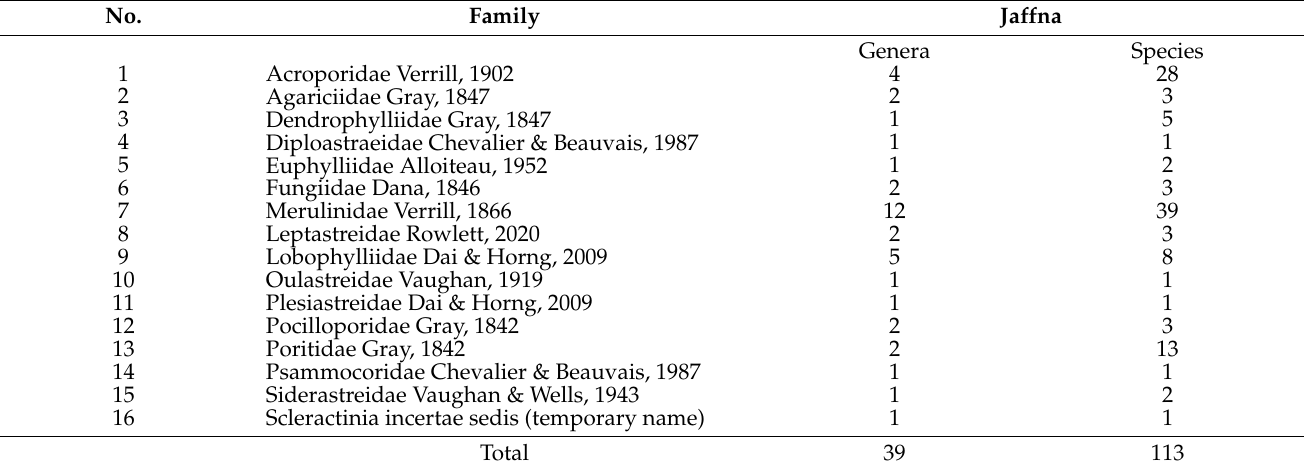
Figure 5. Principal component analysis (PCA) showing the pattern of differences between study sites and how they correlate with different benthic components (HC- hard coral, SC- soft coral, NIA- dead coral with macroalgae or nutrient indicating algae, SP- sponge, RB- coral rubble, RC- hard substrate of dead coral more than one year old covered by turf algae or encrusting coralline algae, SD- sand, SI- silt, and OT- others (including sea anemones, tunicates, gorgonians, or non-living substrate)). Table 1. List of the coral families recorded, showing the total numbers of genera and species identified from the study area. No. Family